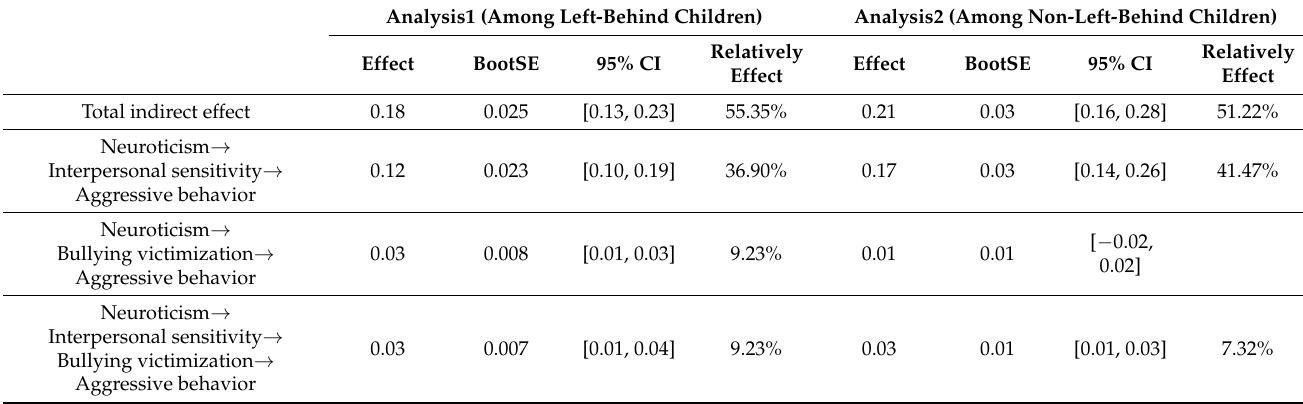
Table 3. The bootstrapping analysis of the mediating